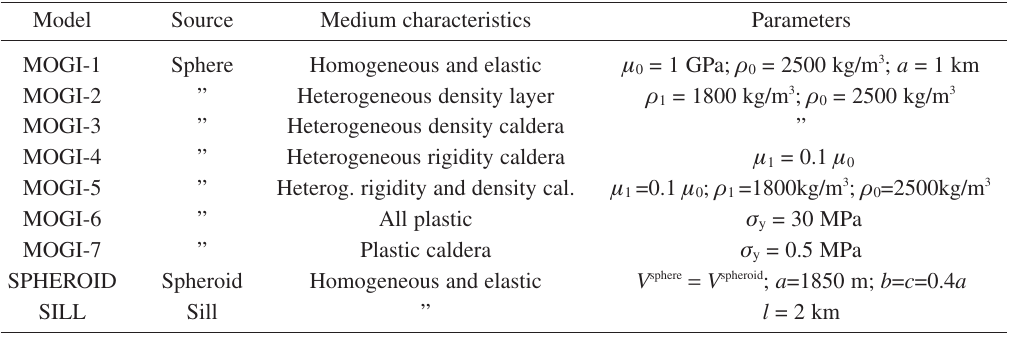
Table I. List of models of which we calculate the gravity variations. The overpressure within the sources is ∆ P= 50 MPa and all the sources are placed at depth d = 5 km. The layer has horizontal interface and a height of 3 km. The caldera has a cylindrical shape of 3 km radius and 3 km height; it lays at the center of the model, co- axial with the sources. The parameters are explained in the text.